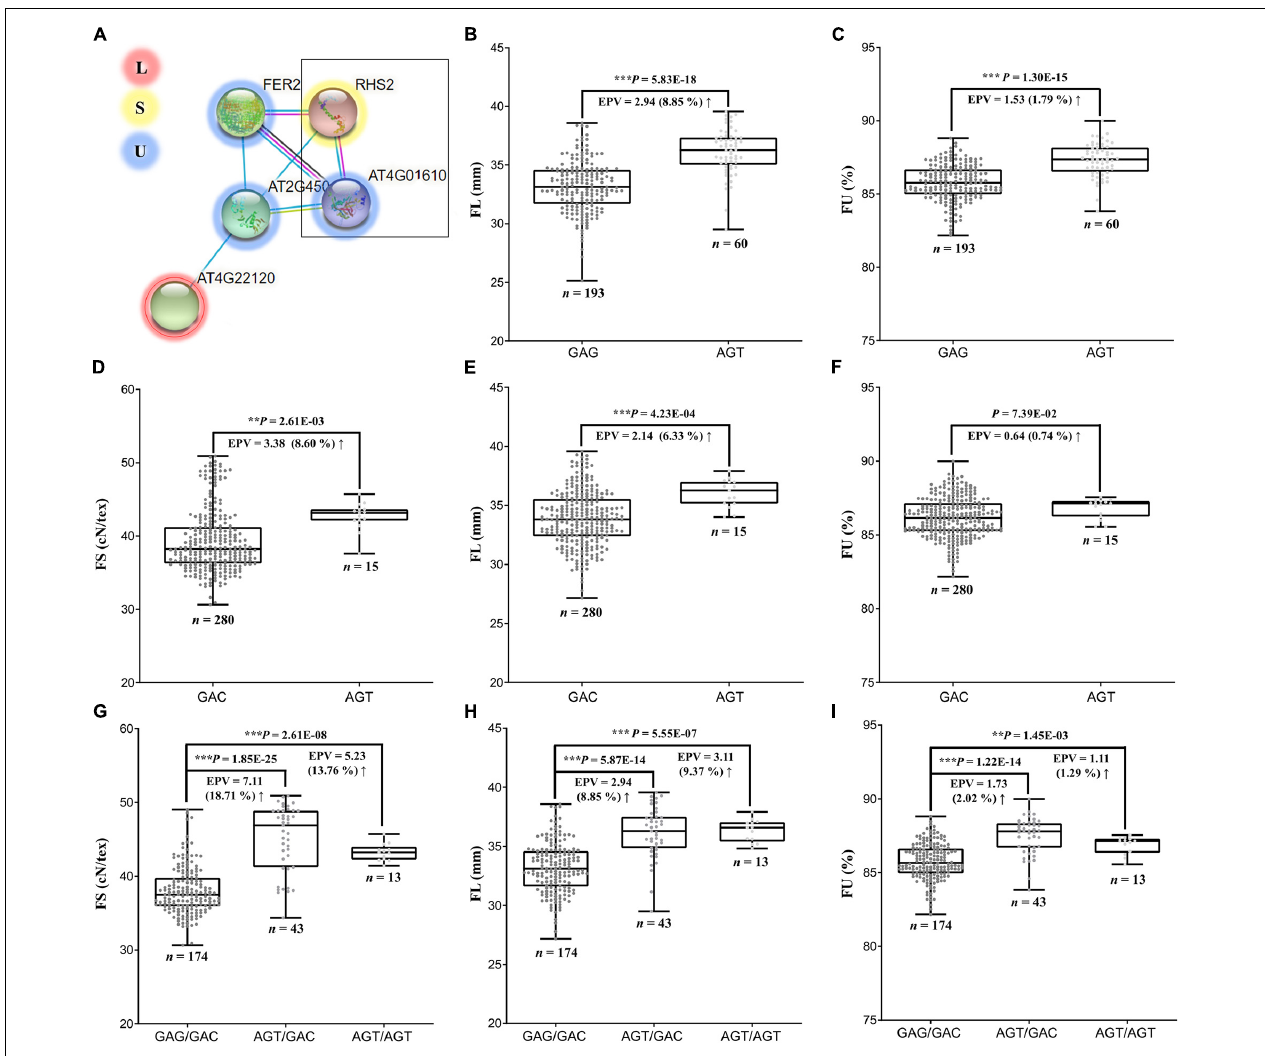
FIGURE 6 | Interaction of genes related to FS, FL and FU, and their effects on phenotypes. (A) Interaction network among genes related to FS, FL, and FU. Arabidopsis RHS2 is homologous to GbCML7 and AT4G01610 is homologous to Gbar_D08G007940 . (B) FL in accessions with two main haplotypes of GbCML7 . n represents the number of accessions with that specific haplotype. Each point represents one accession. Boxes span the first to third quartiles, center lines represent median values, and whiskers show the minimum and maximum. Significance differences in FS between the two groups of accessions with different haplotypes was analyzed using a two tailed t -test. **, *** indicates significant difference at P < 0.01, 0.001, respectively. The up arrow indicates the increase from the former to the latter. (C) FU in accessions with two main haplotypes of GbCML7 . (D) FS in accessions with two main haplotypes of Gbar_D08G007940 . (E) FL in accessions with two main haplotypes of Gbar_D08G007940 . (F) FU in accessions with two main haplotypes of Gbar_D08G007940 . (G) FS in accessions with the three main interacting haplotypes of GbCML7 and Gbar_D08G007940 . (H) FL in accessions with the three main interacting haplotypes of GbCML7